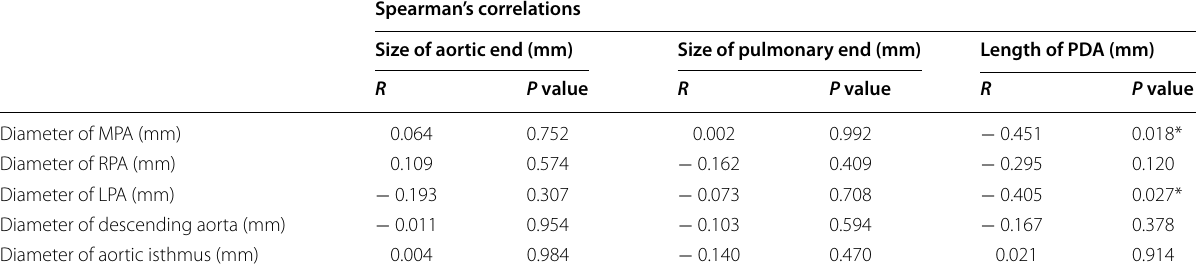
* significant p value (< 0.05)